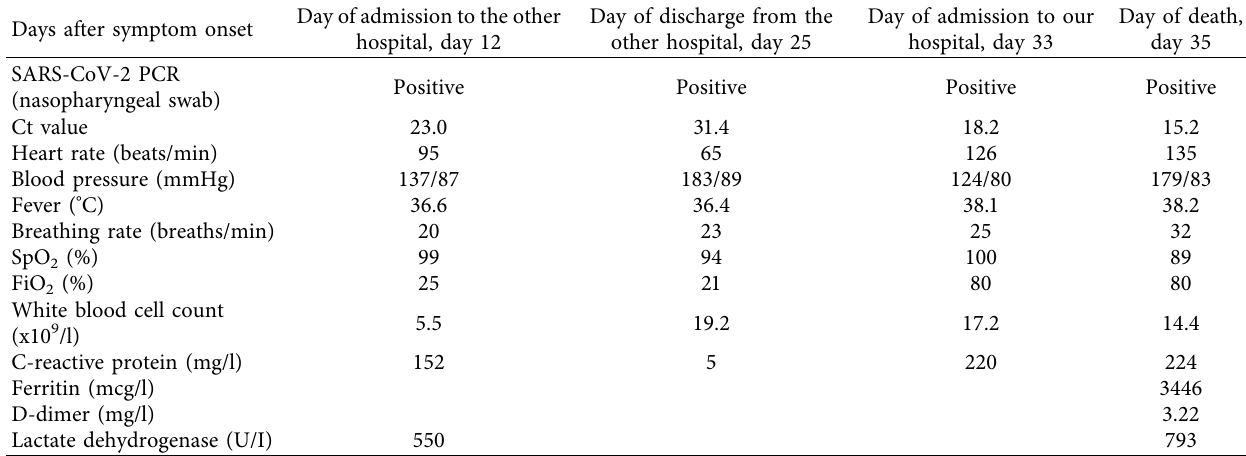
Table 1: Timeline of clinical and laboratory data during